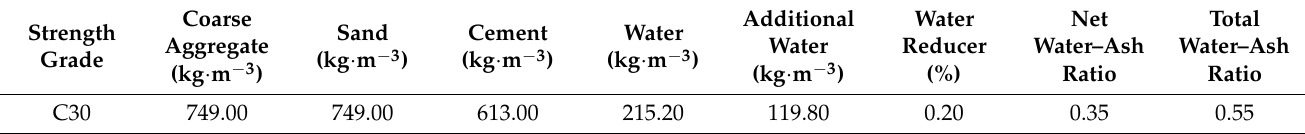
Table 4. Concrete mix ratio